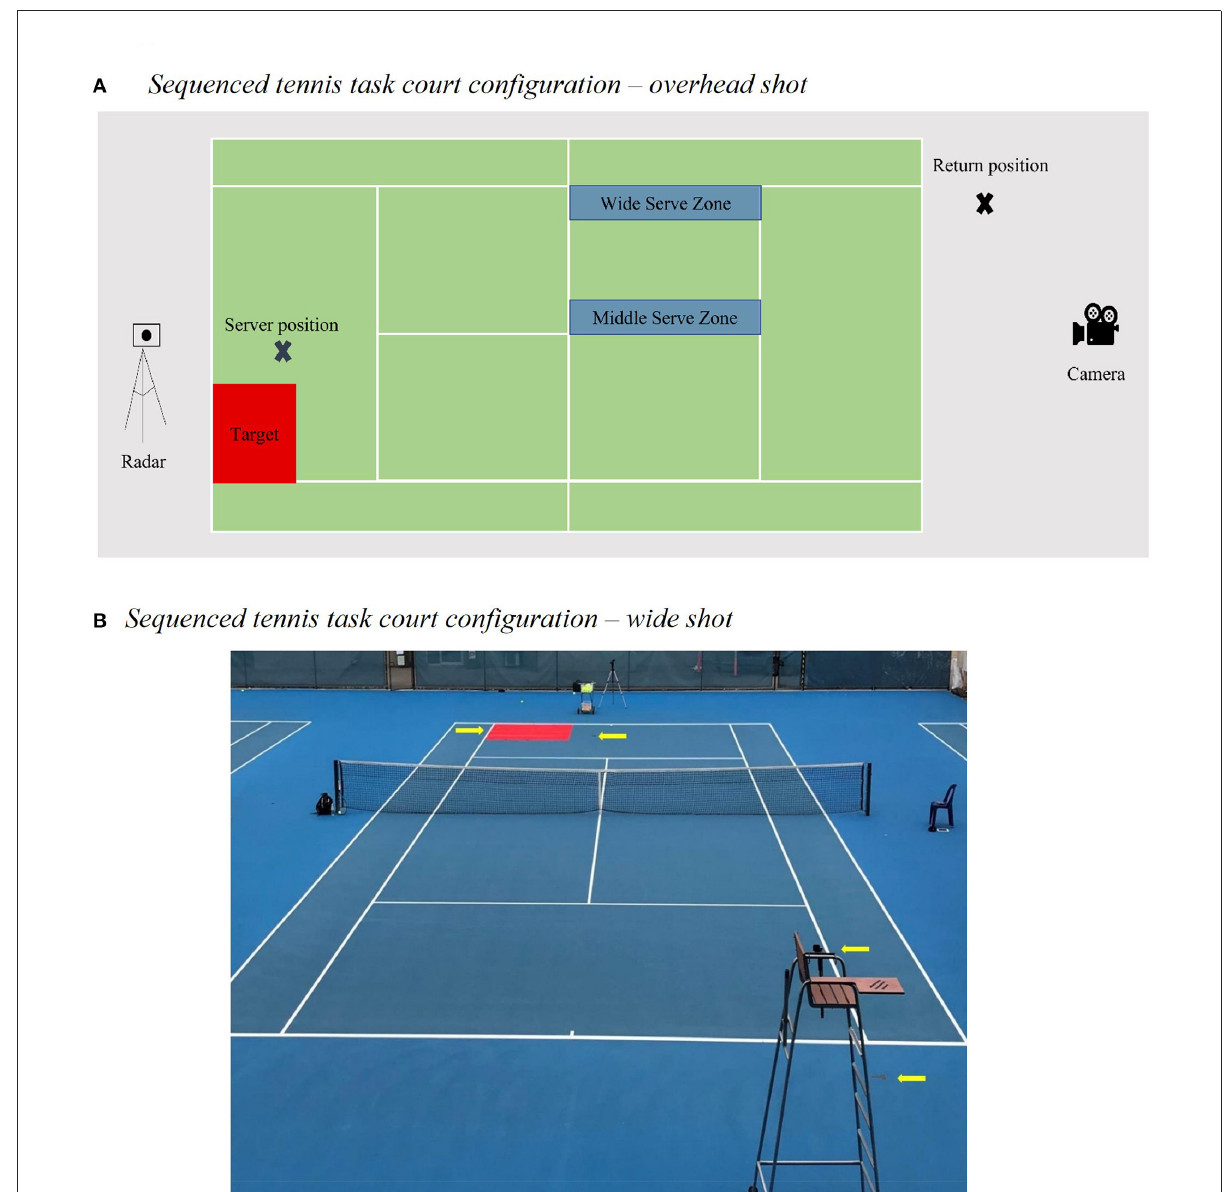
FIGURE1 Tennis court configuration for implicitly sequenced serve return task.